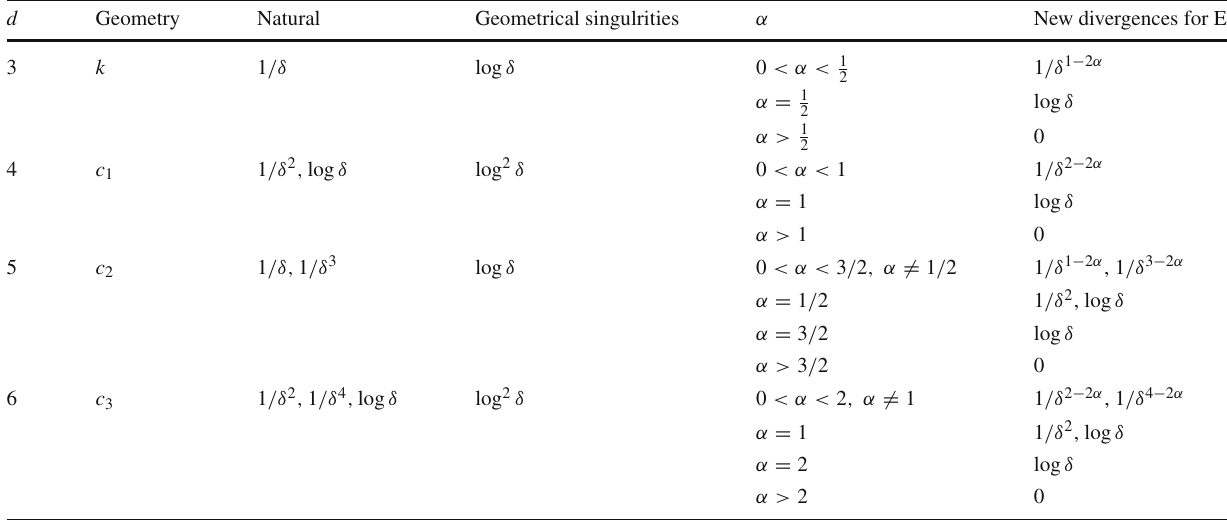
Table 1 Entanglement entropy for kink-cones d